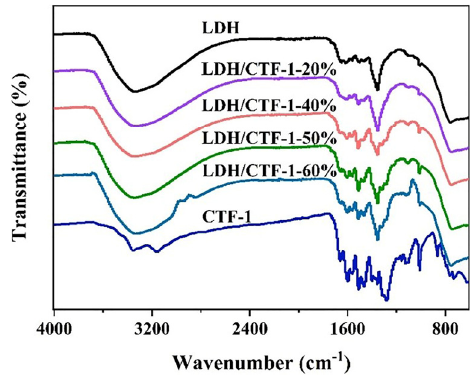
Figure 2. FT-IR spectra of pure LDH, CTF-1, and the LDH/CTF-1 nanocomposites.